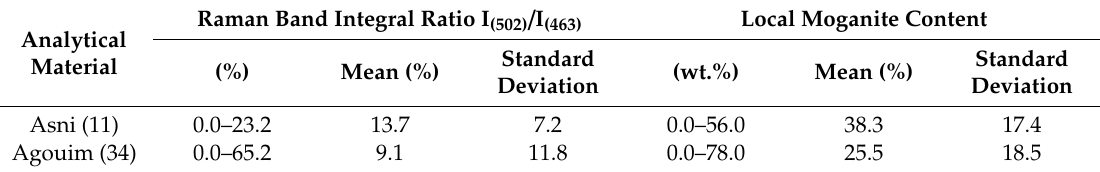
Table 2. Local moganite content and integral ratio of 502 cm − 1 and 463 cm − 1 Raman bands in agate samples from Asni and